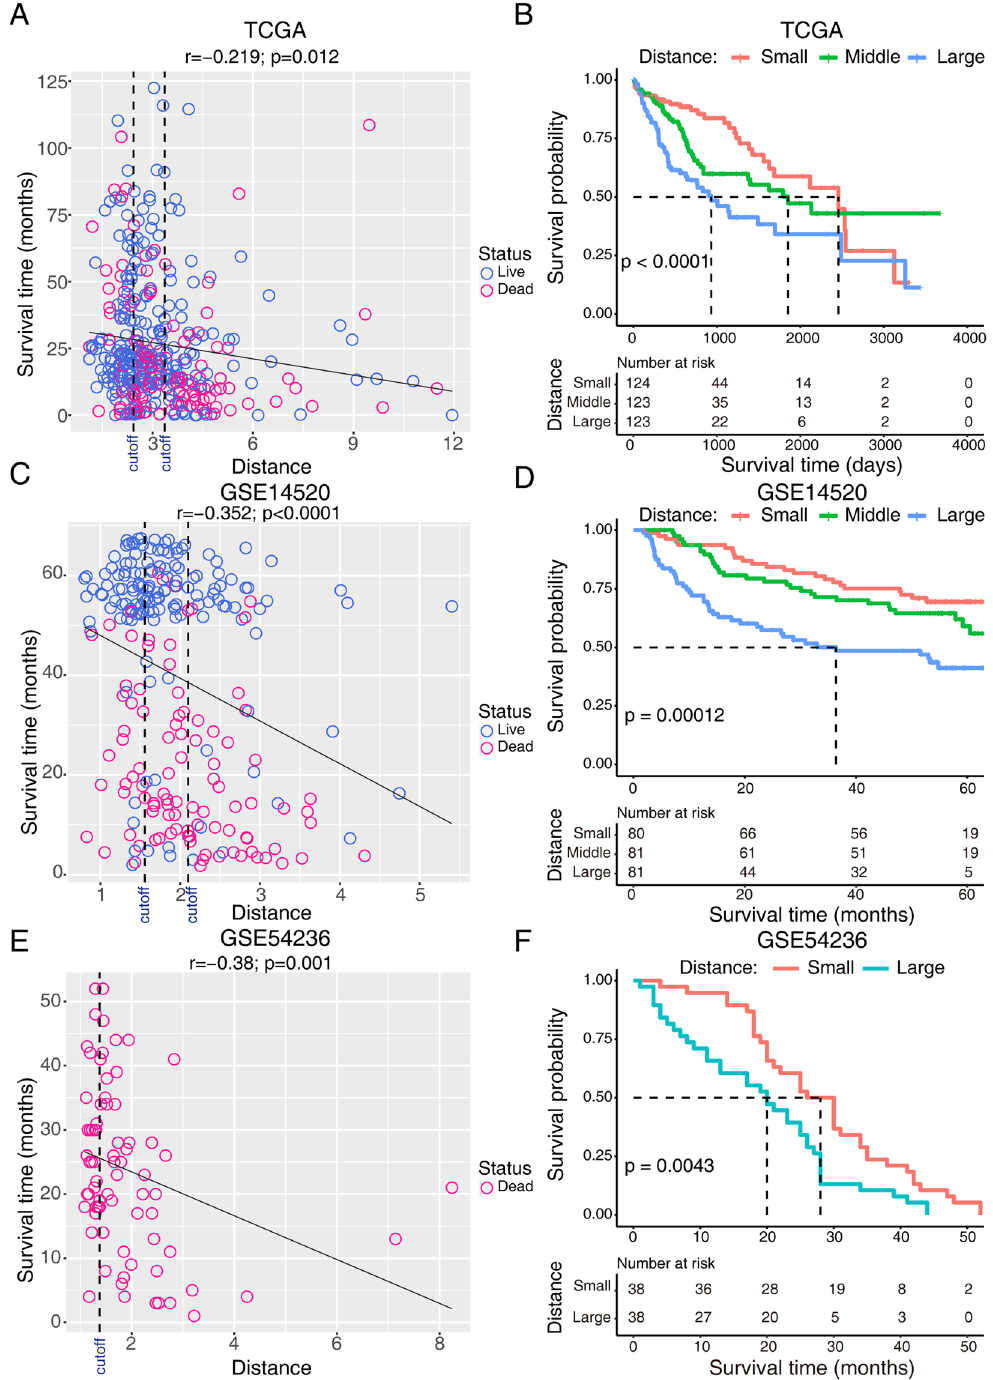
Figure 7. Correlations between mean expression distance and the prognosis of patients with HCC. Scatterplots of survival time and mean expression distance in the ( A ) TCGA, ( C ) GSE14520, and ( E ) GSE54236, where survival time (y axis) is plotted against mean expression distance (x axis). Blue and pink represented patients with live or dead survival status, respectively. Black dashed line represents the cut-off value for dividing patients into different groups. The survival curves of different groups in the ( B ) TCGA, ( D ) GSE14520, and ( F ) GSE54236